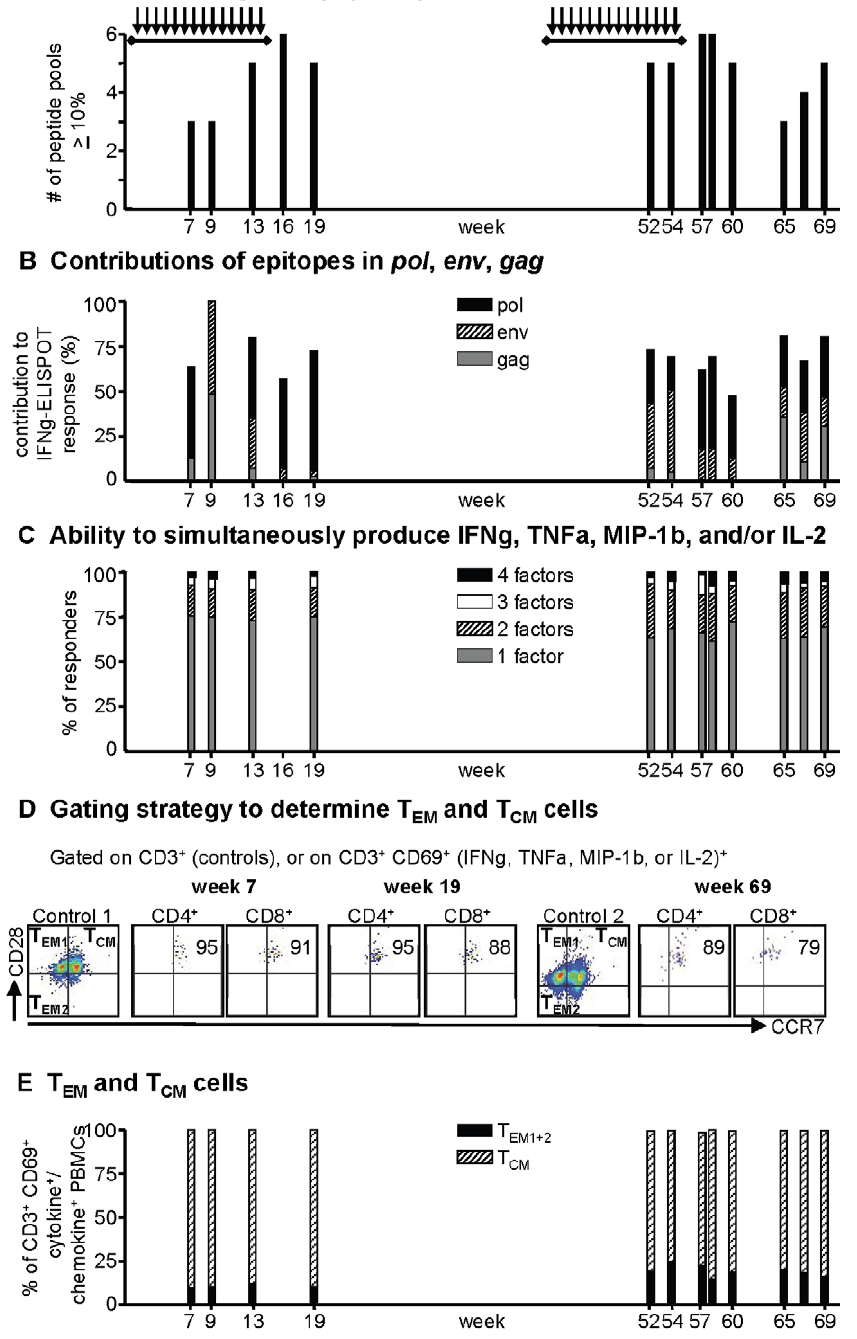
Figure 5. Epitope specificity and differentiation parameters of anti-SHIV T cells in chemo-vaccinated macaque 35451. A: Number of recognized peptide pools: As a measure of the breadth of T cell diversity, the number of peptide pools recognized was examined. Only pools recognized with 10% or more of the anti-SHIV T cell ELISPOT response are shown. B: Contributions of epitopes in pol , env , gag : T cells to products of pol , env , and gag are depicted as percentage of the total IFN c -ELISPOT response. C. Ability to simultaneously produce multiple cytokines/chemokines. Intracellular production of IFN c , TNF a , MIP-1 b , and/or IL-2 (‘‘factors’’) was measured by flow cytometry after gating on CD3 + CD69 + cells. Freeze-thawed PBMCs were cultured with 2 dominant peptide pools as determined by ELISPOT for each time point. We determined the number of cells that produced any of the factors (‘‘responders’’), and then analyzed whether the cells made any one factor alone, any two or three factors, or all four factors simultaneously. D. Gating strategy for determination of anti-SHIV effector and central memory T cells (T EM and T CM , respectively). Cells were stimulated as described in C . For the indicated control analyses, CD3 + gated cells were analyzed for CD28 or CCR7 expression, thus defining transitional T EM1 , T EM2 , and T CM quadrants for samples analyzed on the same day, i.e. from weeks 7 or 19 (control 1) or from week 69 (control 2). The same quadrants were applied to anti-SHIV T cells (CD3 + , CD69 + , and [IFN c + , TNF a + , MIP-1 b + , and/or IL-2] + ), after further gating on CD4 + or CD8 + cells. The numbers in the upper right quadrants refer to T CM cells as percentage of anti-SHIV CD4 + or CD8 + cells. E: T EM (T EM1 and T EM2 ) and T CM cells are shown as percentage of anti-SHIV T cells (CD4 + or CD8 + cells) , as determined by flow cytometry described in C and D . Arrows indicate virus exposures, horizontal bars depict PrEP treatment. doi:10.1371/journal.pone.0019295.g005 PLoS ONE |